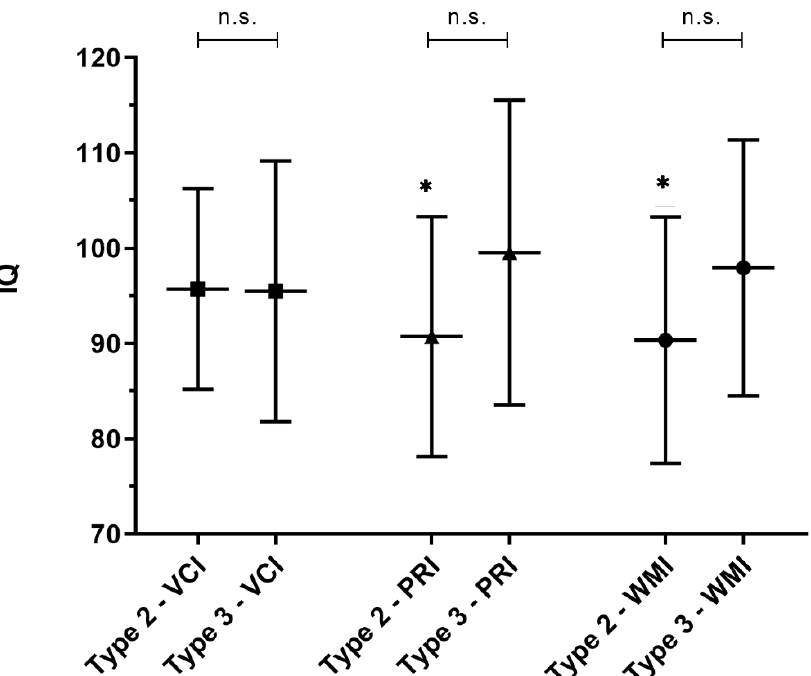
Figure 2. Intelligence quotient (IQ) of the patients with SMA types 2 and 3. The IQ of the VCI, PRI, and WMI subcategories of the patients with SMA type 2 ( n = 15) and SMA type 3 ( n = 17). The mean of normal population is 100. The IQ of the PMI and WMI of the patients with SMA type 2 are significantly reduced (*) compared to the normal population. The IQ of the patients with SMA type 2 compared to type 3 did not differ (n.s.) in the VCI ( p = 0.95), PRI ( p = 0.097), and WMI ( p = 0.115).